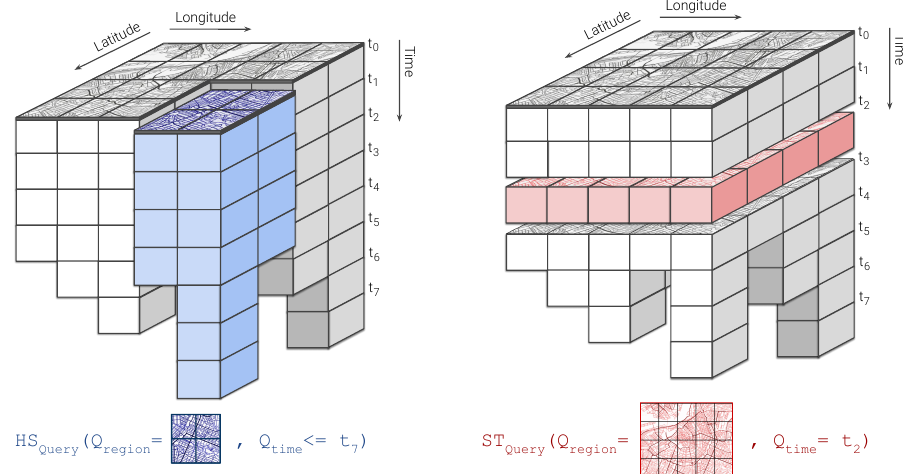
Figure 5. Query resolution on continuous views: The diagram on the left describes an HS query requesting the historical behaviour of the observed variable over Q region , while the one to the right shows an ST query requesting the state of the observed variable at instant Q time = t 2 .